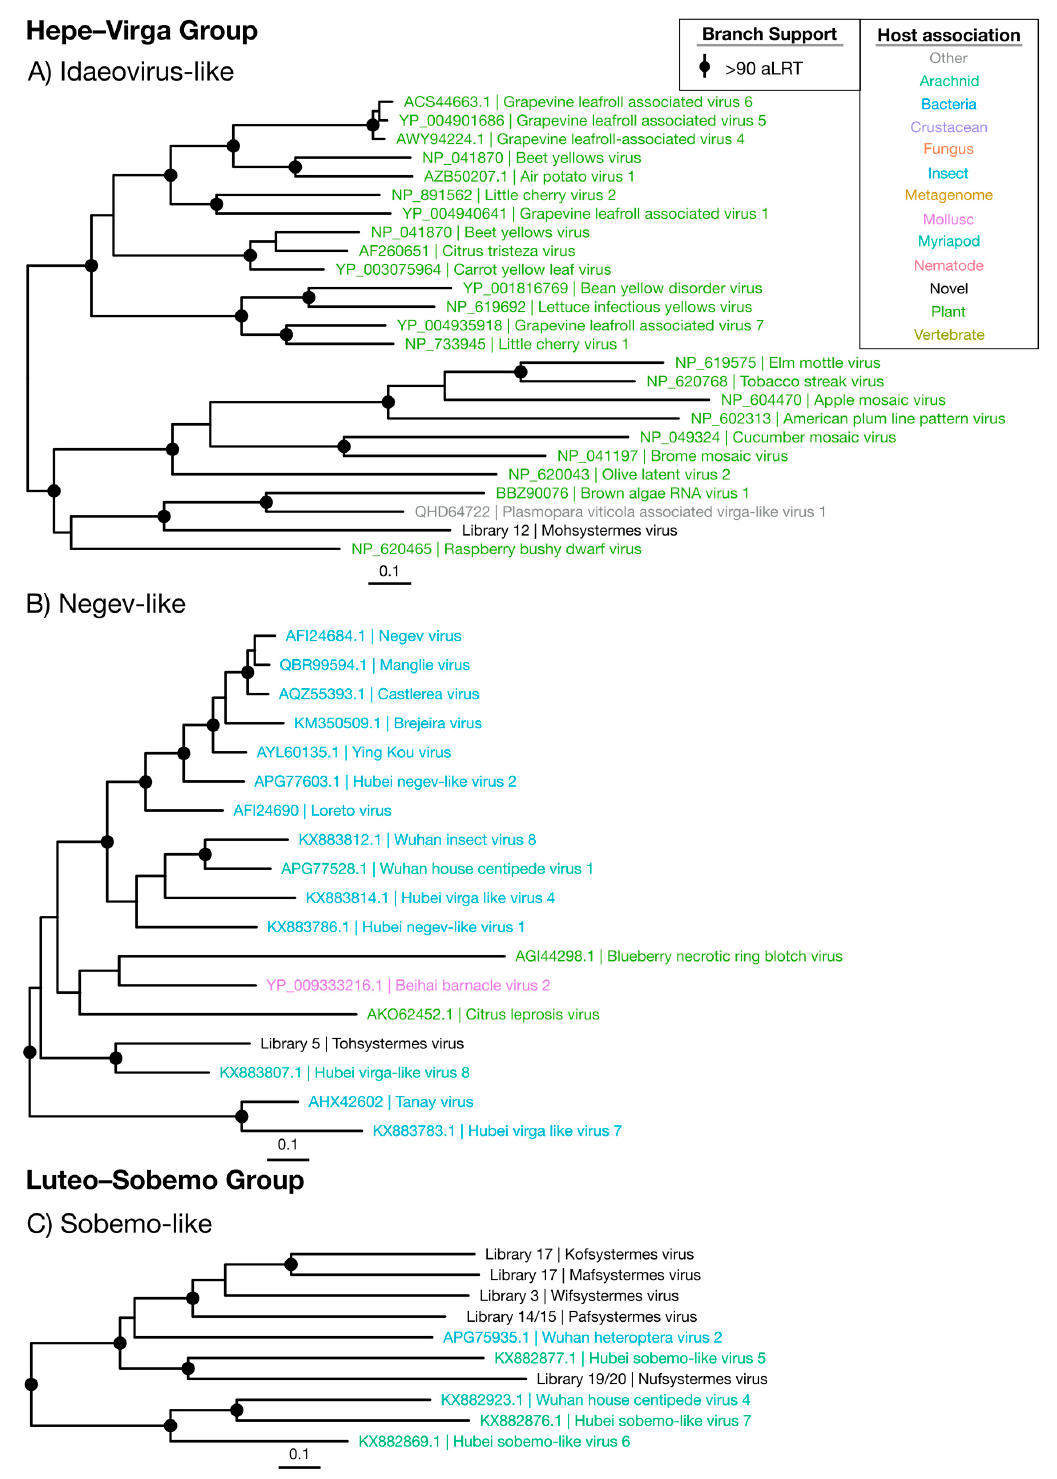
Figure 3. Phylogenetic trees of the viruses newly discovered here and their relatives in the Hepe–Virga and Luteo–Sobemo groups. Newly identified viruses are labeled with black text in the format “<Library # | Virus name>”, while related viruses are colored by their host association and are labeled in the format “<Replicase protein accession> | <Virus name>”. Black dots at tree nodes indicate high branch support (aLRT > 90).